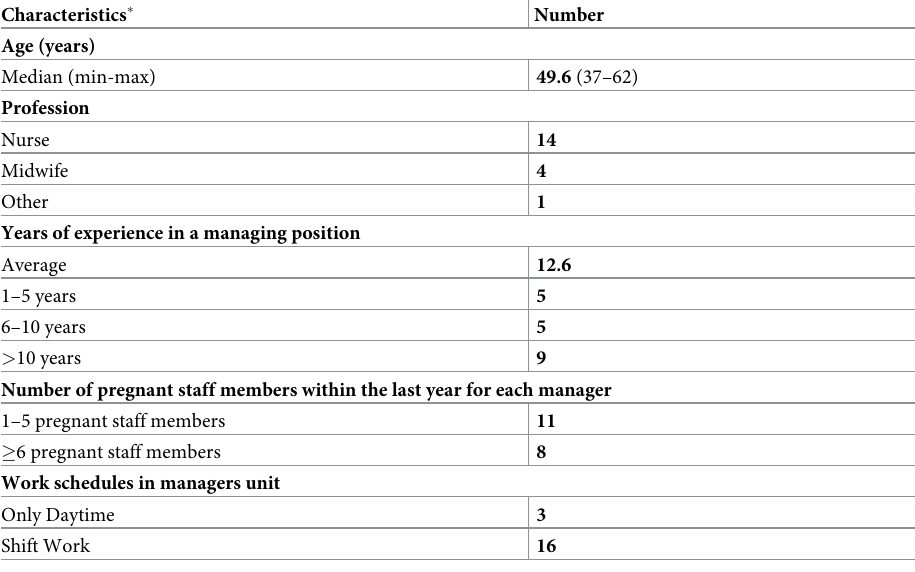
Table 1. Characteristics of the study participants (n = 19). Characteristics